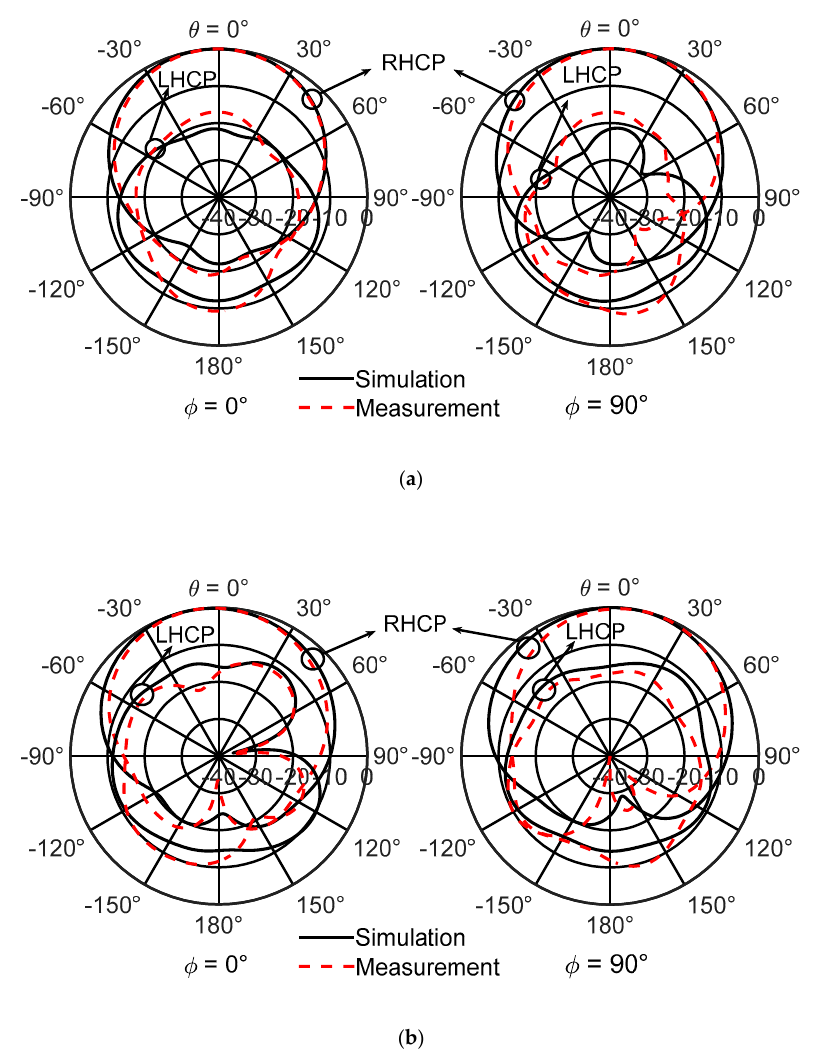
Figure 15. Measured and simulated radiation patterns of the right hand circularly polarized antenna. ( a ) 2.6 GHZ and ( b ) 2.9 GHz.